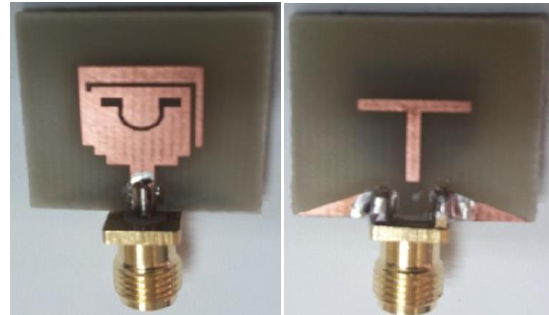
Figure 9: Photograph of the proposed fabricated tri-band notched UWB antenna.